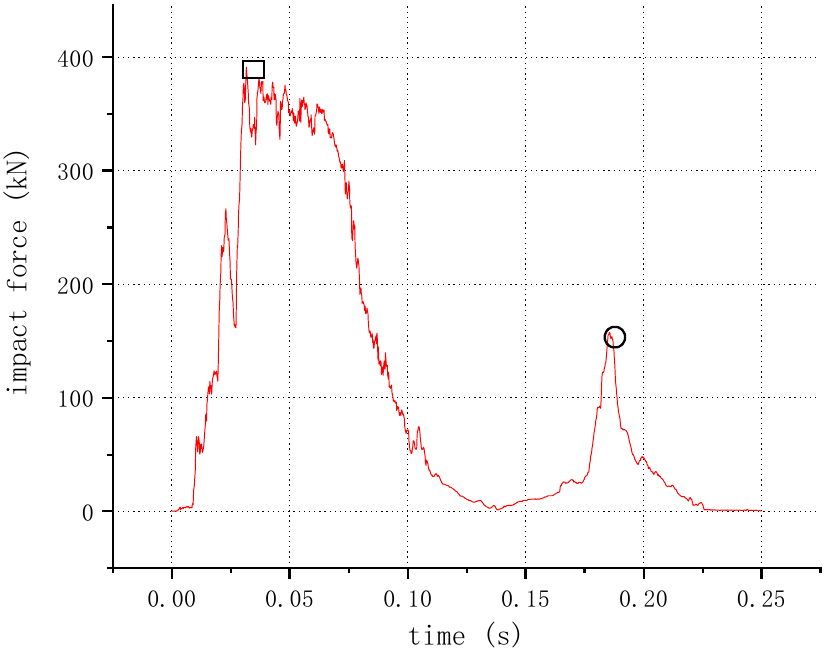
Figure 19. Time–impact force of sample N1. □ : a front impact; ○ : a tail impact.